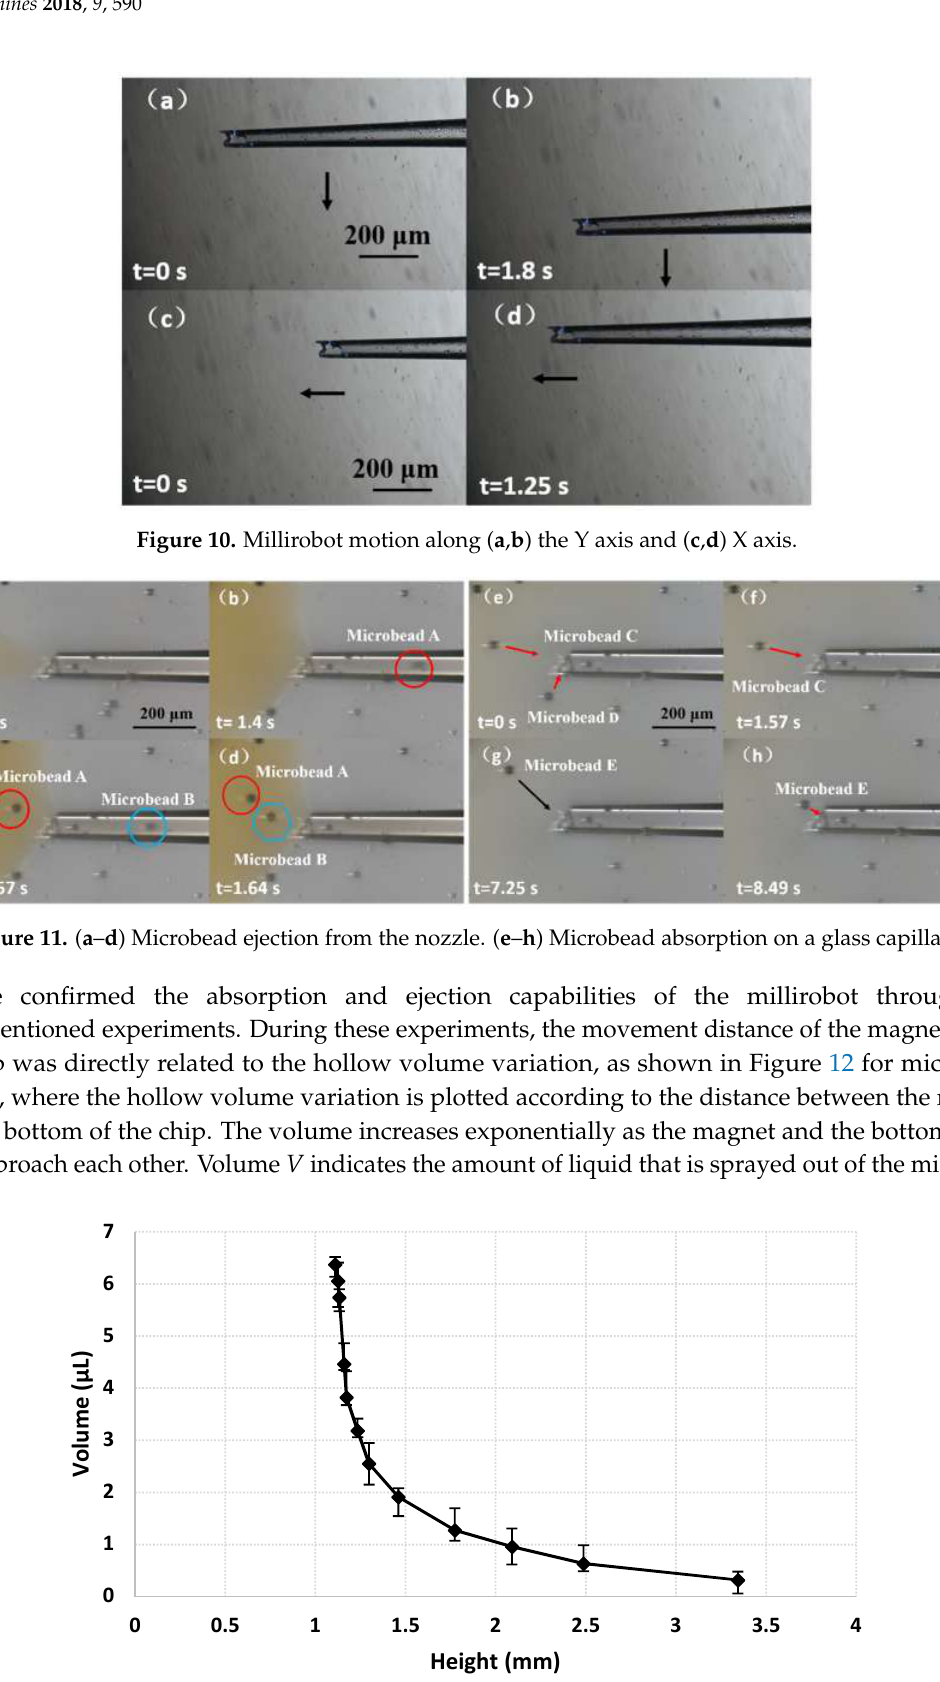
Figure 12. Relation between hollow volume and distance between the permanent magnet and the microfluidic chip during particle ejection.